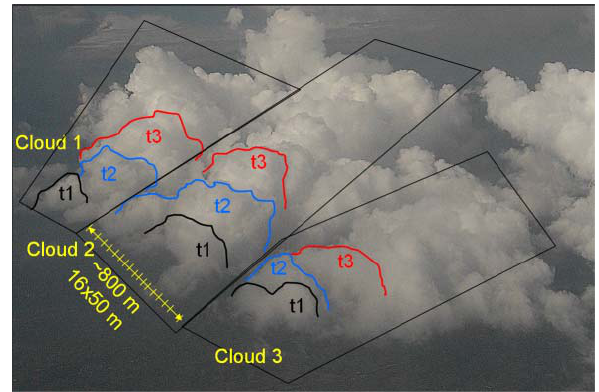
Fig. 6. Illustration of the topography of three small convective cloud segments. The contours show the possible development lines of the cloud top along three time steps, i.e., three views of the same cloud at t1, t2 and t3. These identifiable cloud features just above cloud base develop vertically at a similar rate as the cloud base updraft. The MAI 50m resolution is illustrated at the scale bar. The resolu- tion appears to be sufficient for mapping the marked perturbations and track these features along a sequence of three 1-min images, and map the average topographies for t1 to t2 and for t2 to t3. The differentiation of the two topographic maps will provide the cloud vertical motion. It appears that the retrieved updraft near cloud base, w b , would be the largest for cloud 1 and the smallest for cloud